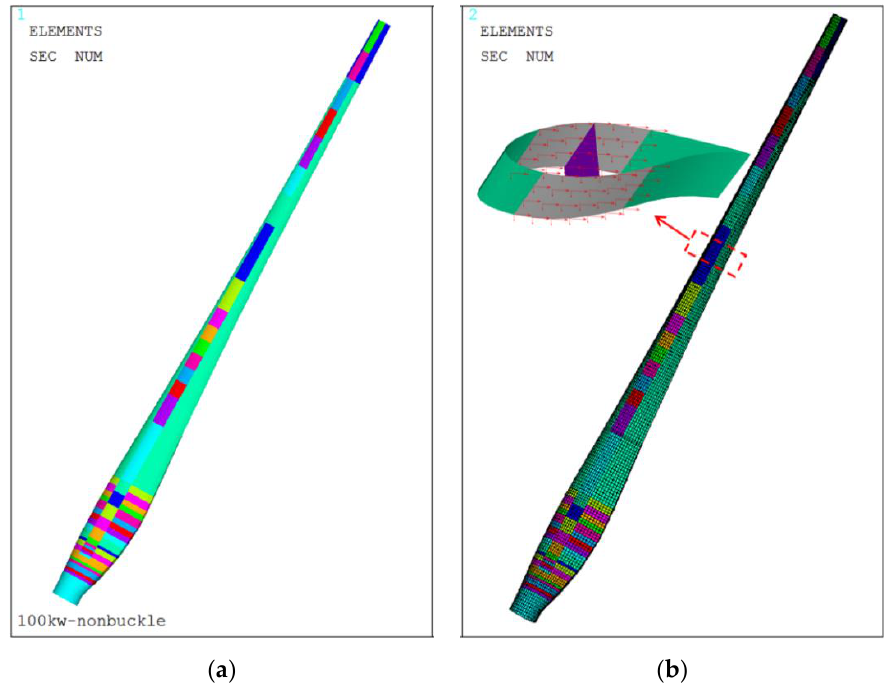
Figure 2. The 3DFEM model of a 100 kW blade: ( a ) Blade laminates in different colors; ( b ) meshes and loading of the blade model.